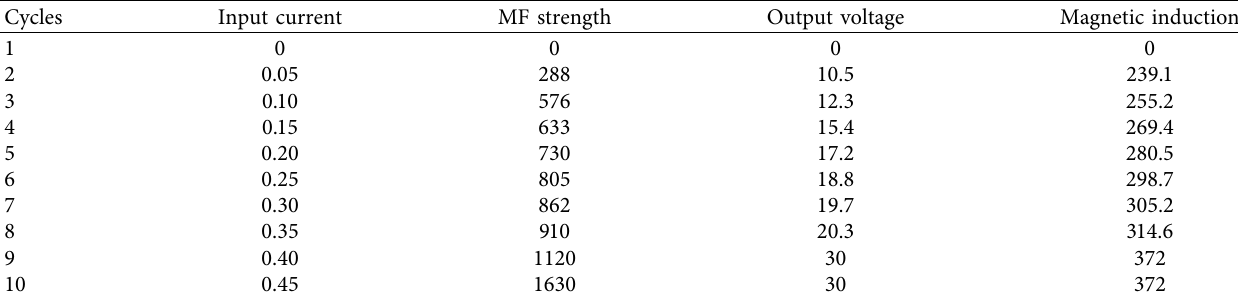
Table 4: The relationship between MF intensity and magnetic induction